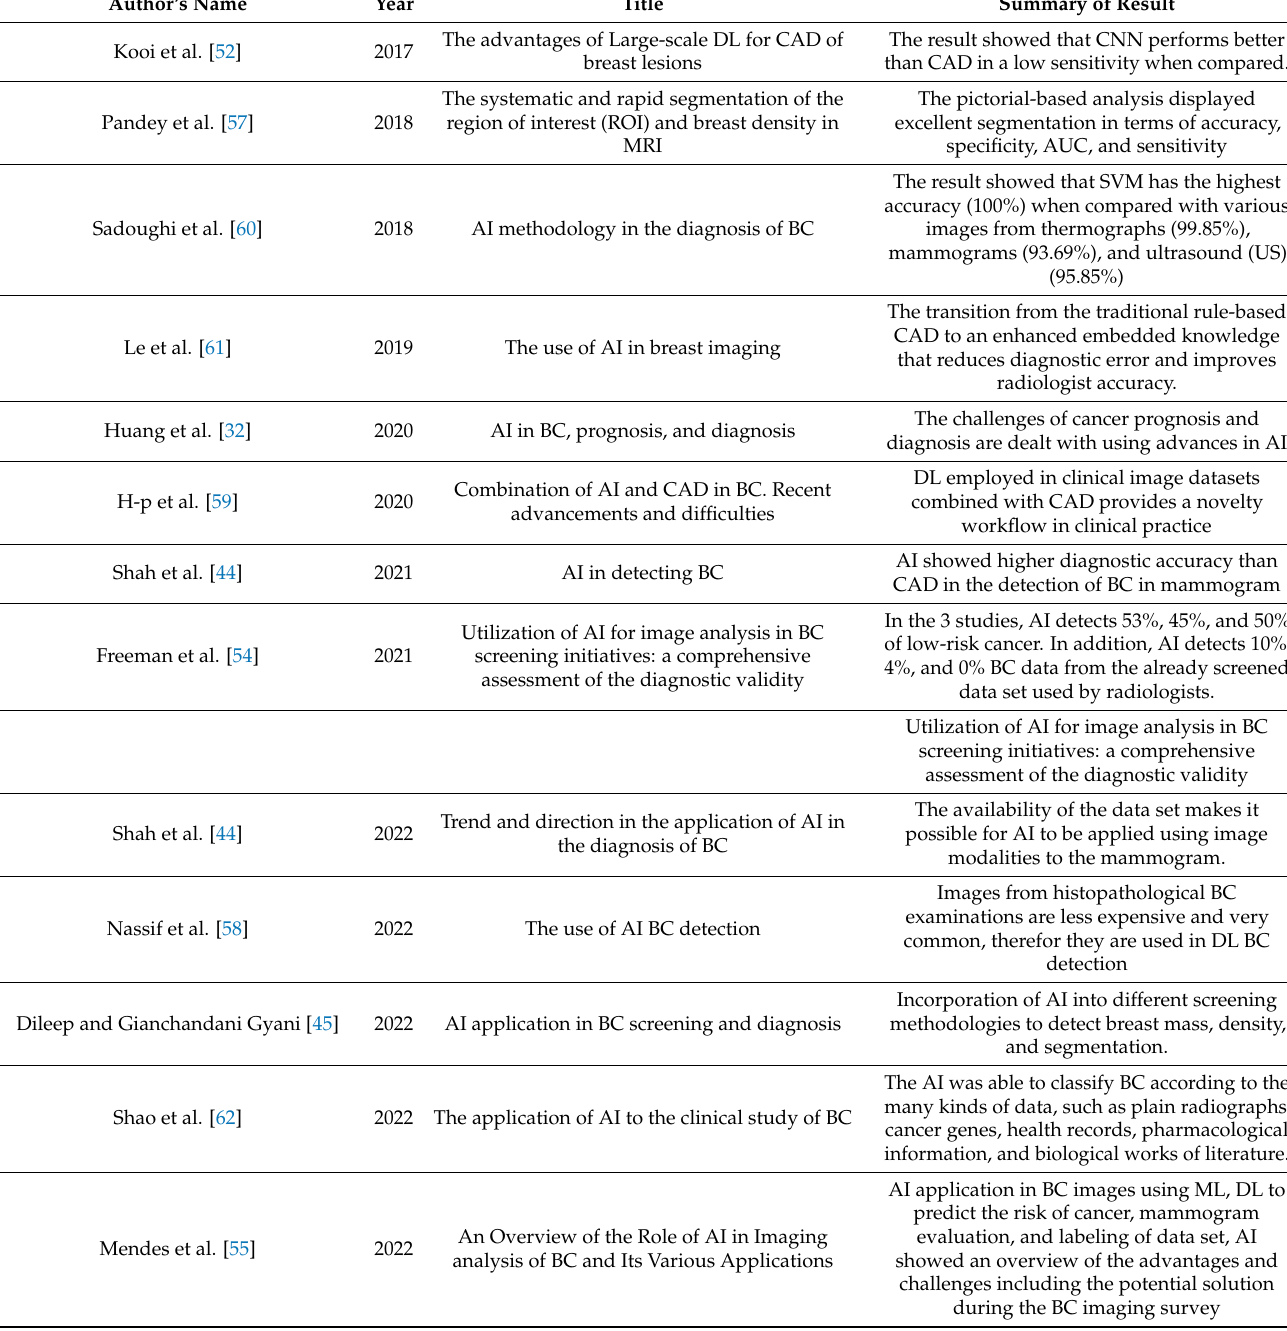
Table 1. Summary of the results of 36